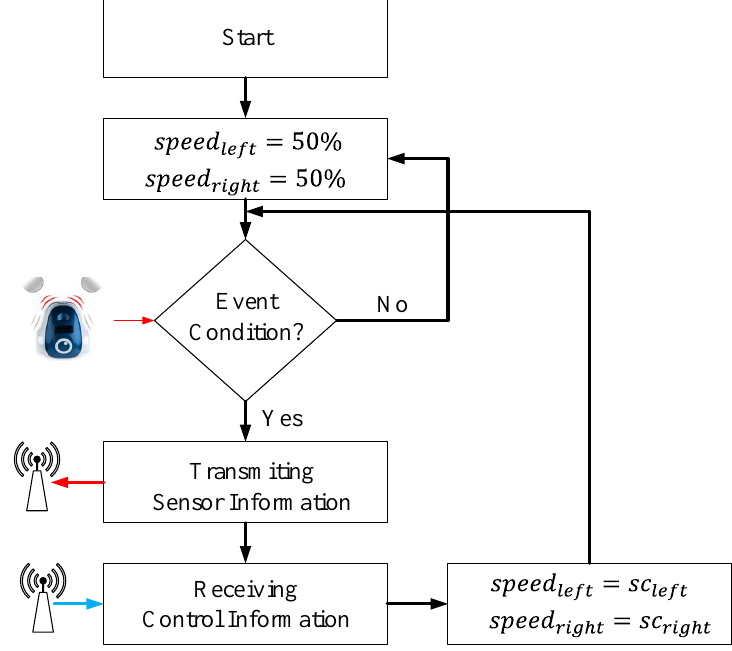
Figure 6. Event-based architecture for the mobile